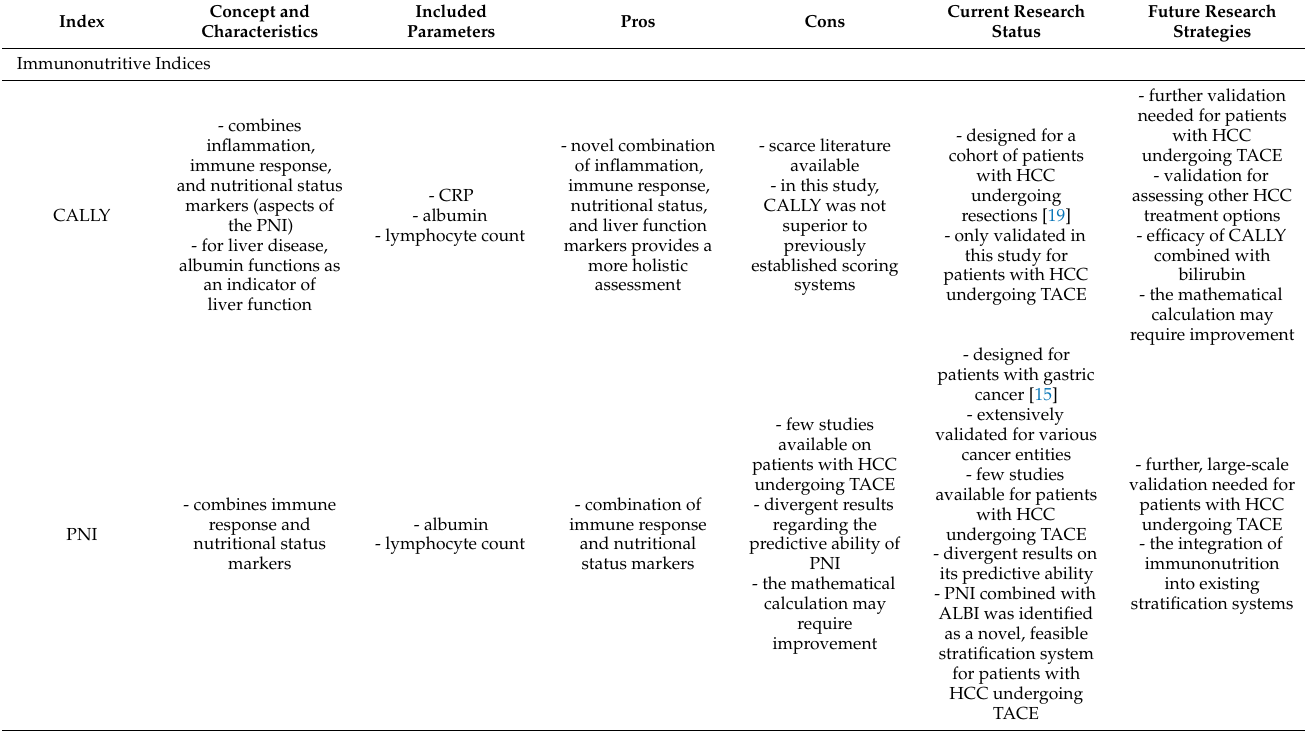
Table 6. Overview of various aspects of the included immunonutritive and immune-based